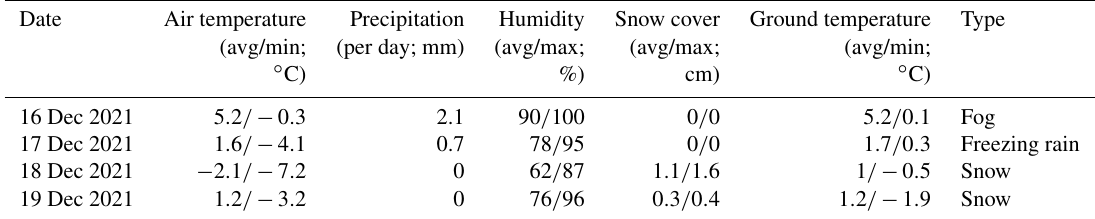
Table 3. A list of scenarios for the system dynamics model. Validate the model by acquiring sensor data from the dates in the list. Date Air temperature Precipitation Humidity Snow cover Ground temperature